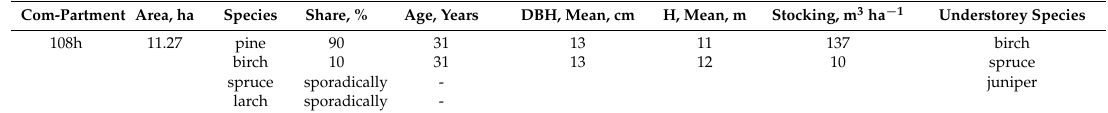
Table 1. Stand characteristics before thinning; general forest inventory data valid on 1 Jan